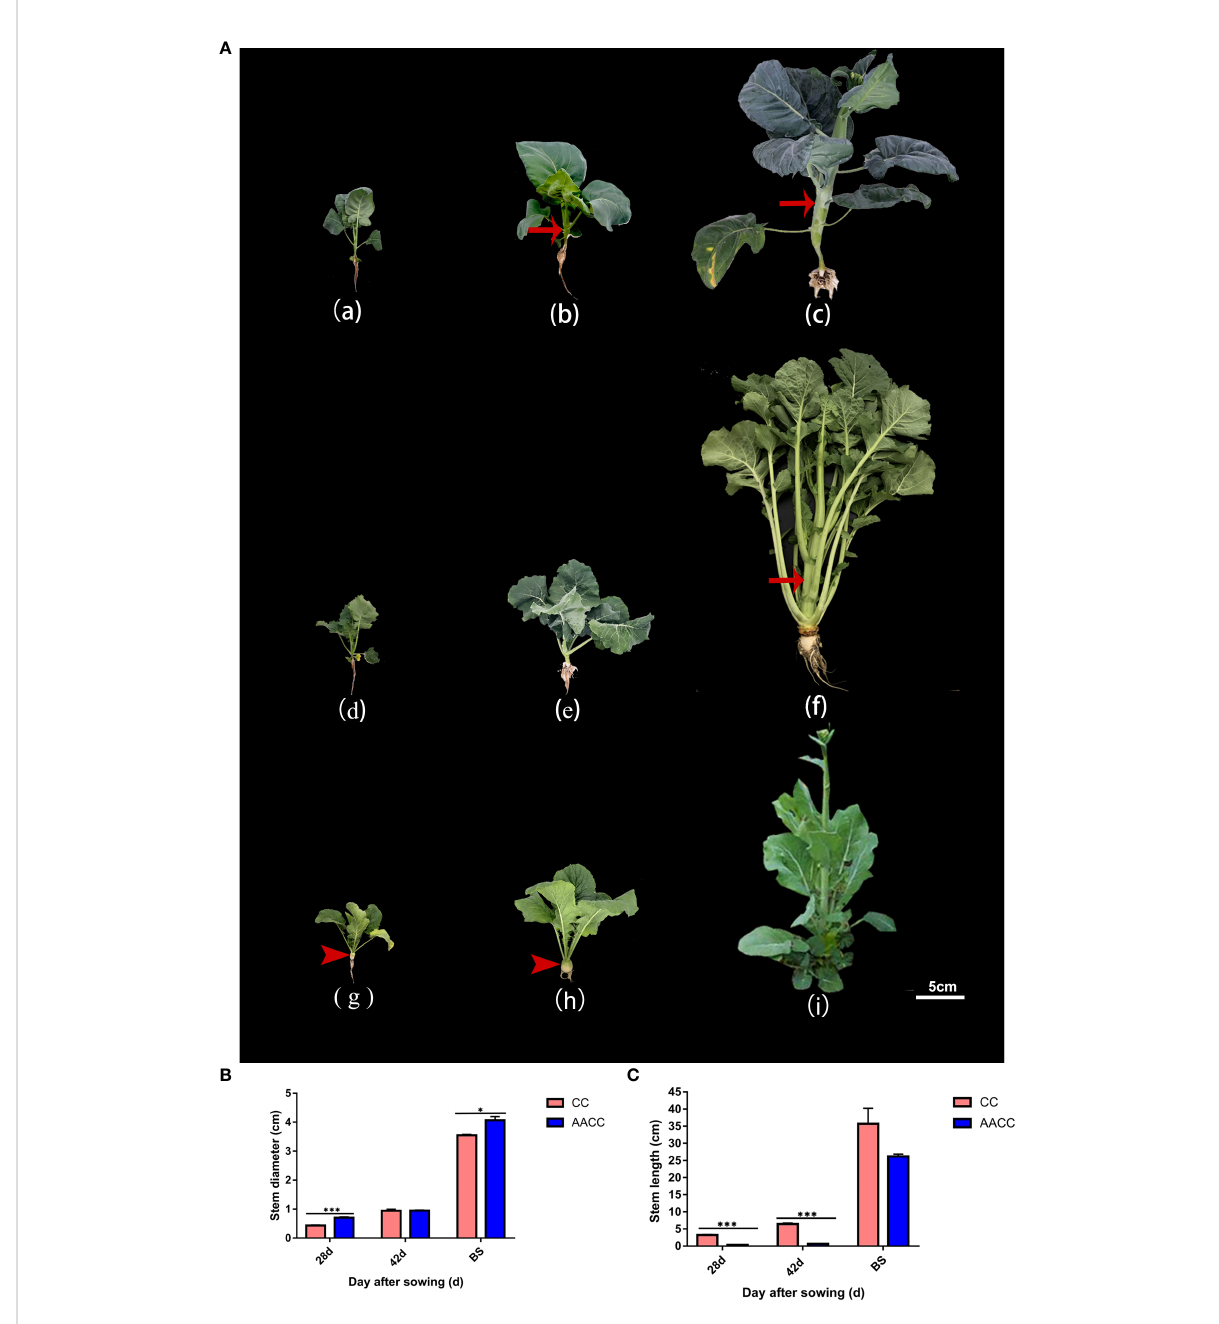
FIGURE 1 Plant morphology of Chinese kale (CC) and its synthetic allotetraploid (AACC). (A) The CC and AACC plants at three stages of 28 DAS, 42 DAS and the bolting stage (BS), respectively. From (a) to (c), they represent Chinese kale at above corresponding stages. From (d) to (f), they represent allotetraploid hybrid at the above corresponding stages. From (g) to (i) they represent ‘ yellow turnip ’ ( B. rapa L. ssp. rapifera Matzg., AA) at the above corresponding stages. Arrow shows the swollen stem. Arrow head shows the fl eshy root of ‘ yellow turnip ’ . Scale bar 5cm. (B) Stem diameter of the CC and AACC plants at different stages, according to the sampling time (i.e., days after sowing), which is presented in the X-axis. Independent sample T-test was performed for CC and AACC in each period. The data shown in the bar graphs are the mean ± SEM of three biological duplications. Error bars indicate standard errors. (C) Stem length of the CC and AACC plants at different stages, according to the sampling time (i.e., days after sowing), which is presented in the X-axis. Independent sample T-test was performed for CC and AACC in each period. The data shown in the bar graphs are the mean ± SEM of three biological duplications. Error bars indicate standard errors. The asterisks indicate statistical signi fi cance: * p <0.05, *** p